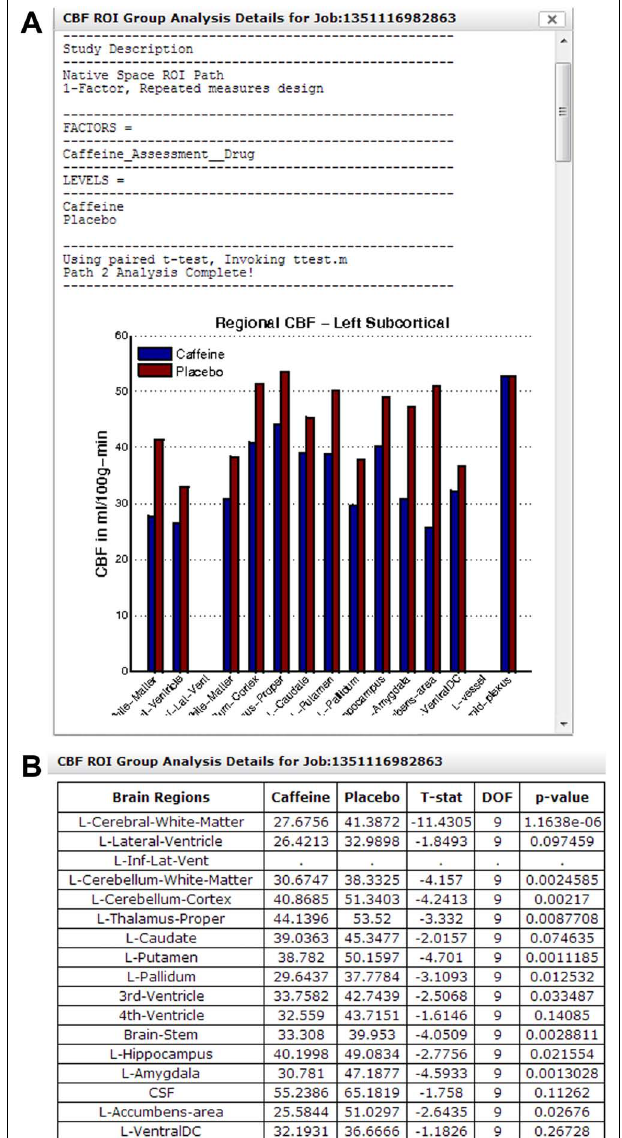
FIGURE 14 | (A) A section of the group analysis report from a caffeine study processed using Group Analysis Path 2.The graph at the bottom shows a widespread reduction in CBF for all regions after caffeine consumption. (B) A section of the system-generated CSV file, summarizing CBF changes in each brain region and associated paired t -test result/ p -value.